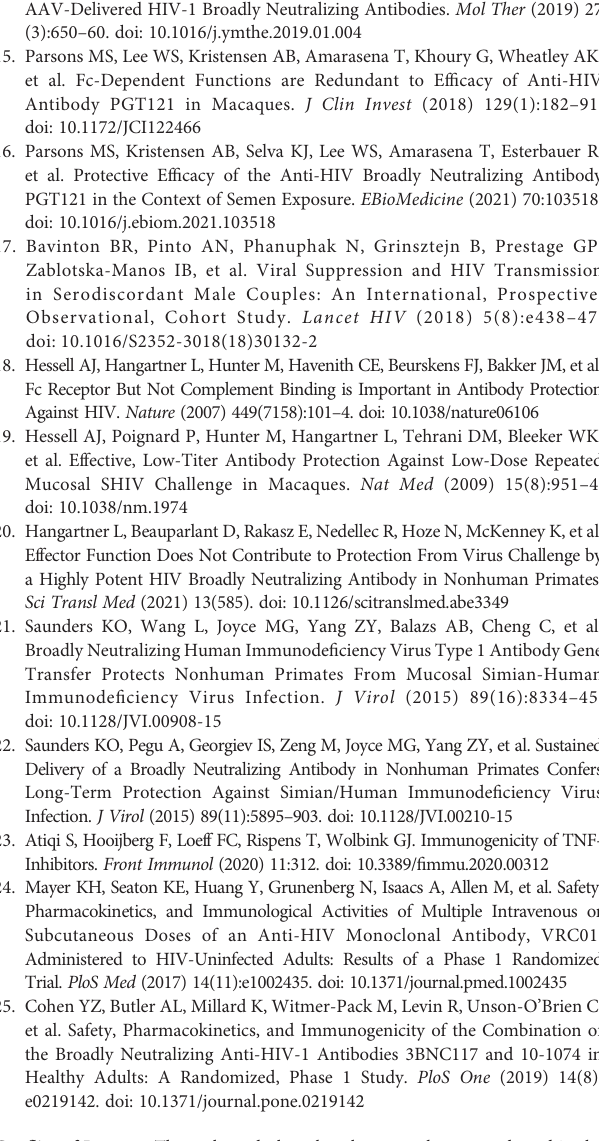
while red arrows indicate SHIV challenge. The numbers in red indicate the viral load decay rate (per day) within 72 hours of therapeutic PGT121 WT or PGT121 LALA administration. Supplementary Figure 2 | Mean levels of anti-PGT121 ADA, plasma concentration of PGT121 and corresponding SHIV viral loads in macaques NM02, NM03 and NM08. The mean plasma concentrations of PGT121 WT or LALA post- infusion (open circles, lefty-axis) are plotted with the mean levels of anti-PGT121 ADA (blue line, right y-axis) and mean SHIV viral loads (red line, right y-axis). Black arrows indicateantibodyadministration.TheredtextindicatesfailedtherapywithPGT121WT or LALA. The data are depicted as the mean and standard error of the